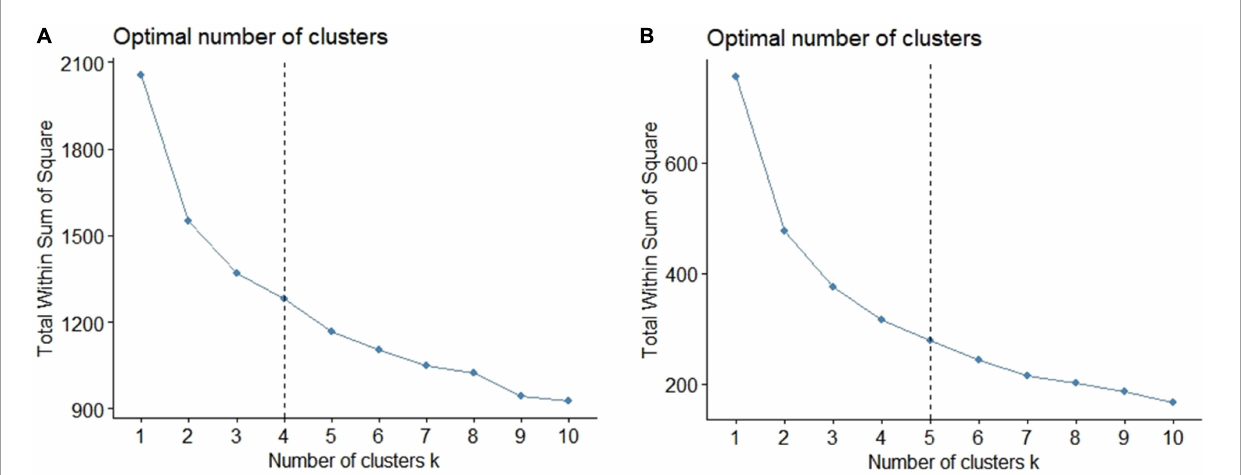
FIGURE1 The elbow diagrams of total within sum of square errors (WSSE). (A) The cluster analysis of NSSI risk factors. The WSSE decline slope of the cluster number from 3 to 5 is almost the same, so solutions comprising of 3, 4, and 5 possible clusters were considered. (B) The cluster analysis of NSSI functions. The WSSE decline slope of the cluster number from 4 to 6 is almost the same, so solutions comprising of 4, 5, and 6 possible clusters were considered.